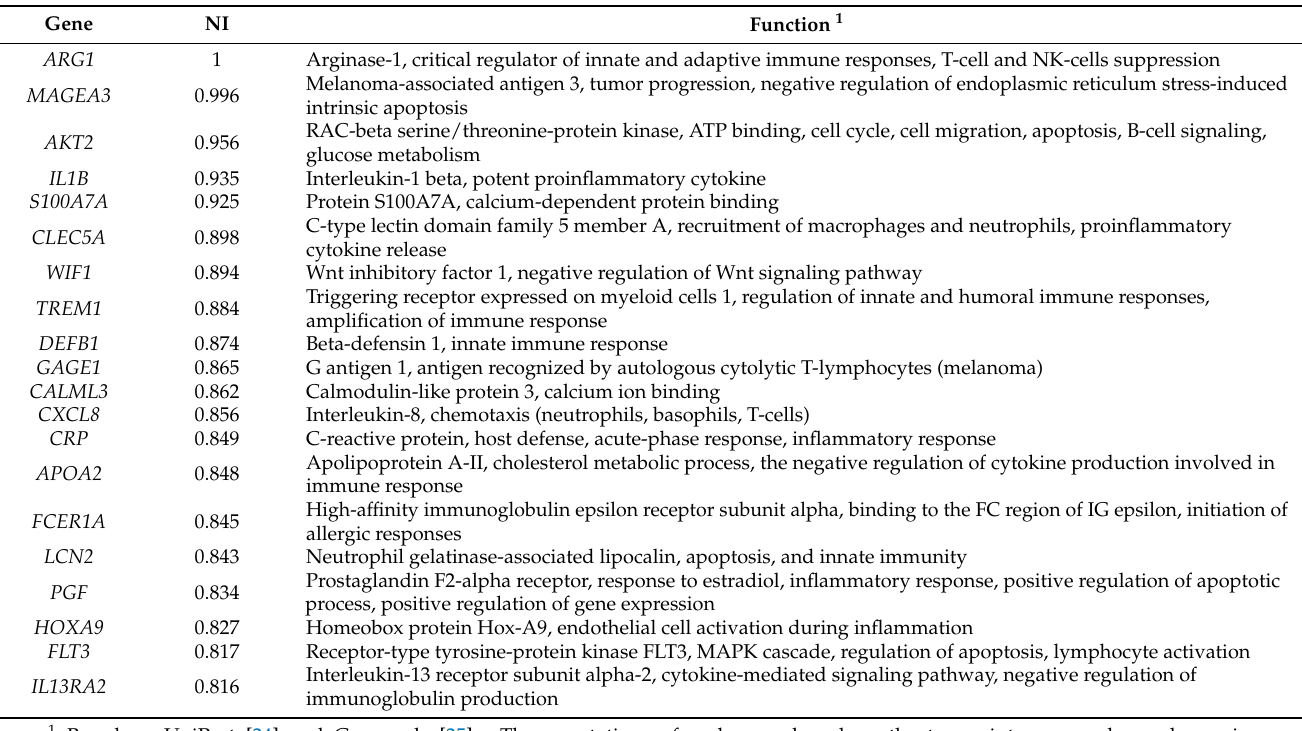
Table 3. Top 20 genes for predicting NHL subtypes (based on the cancer transcriptome panel, n =